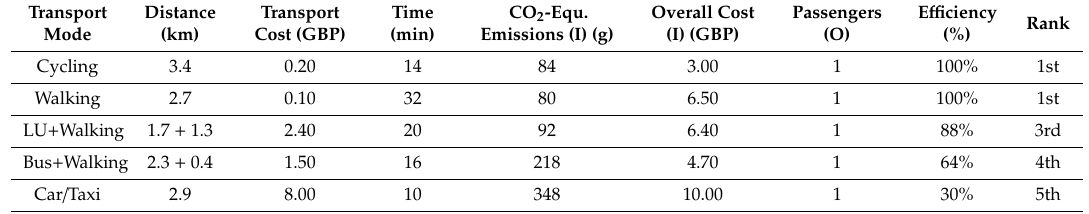
Table 3. Route A. Results in descending order of e ffi ciency of the transport modes DEA model. Transport